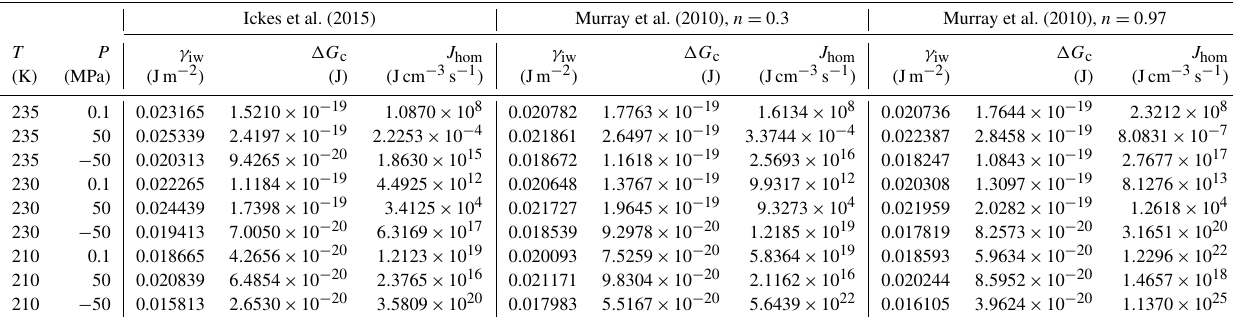
Table D2. Selected values of the CNT parameterizations by Ickes et al. (2015) and Murray et al. (2010). Ickes et al. (2015) Murray et al. (2010), n = 0 .